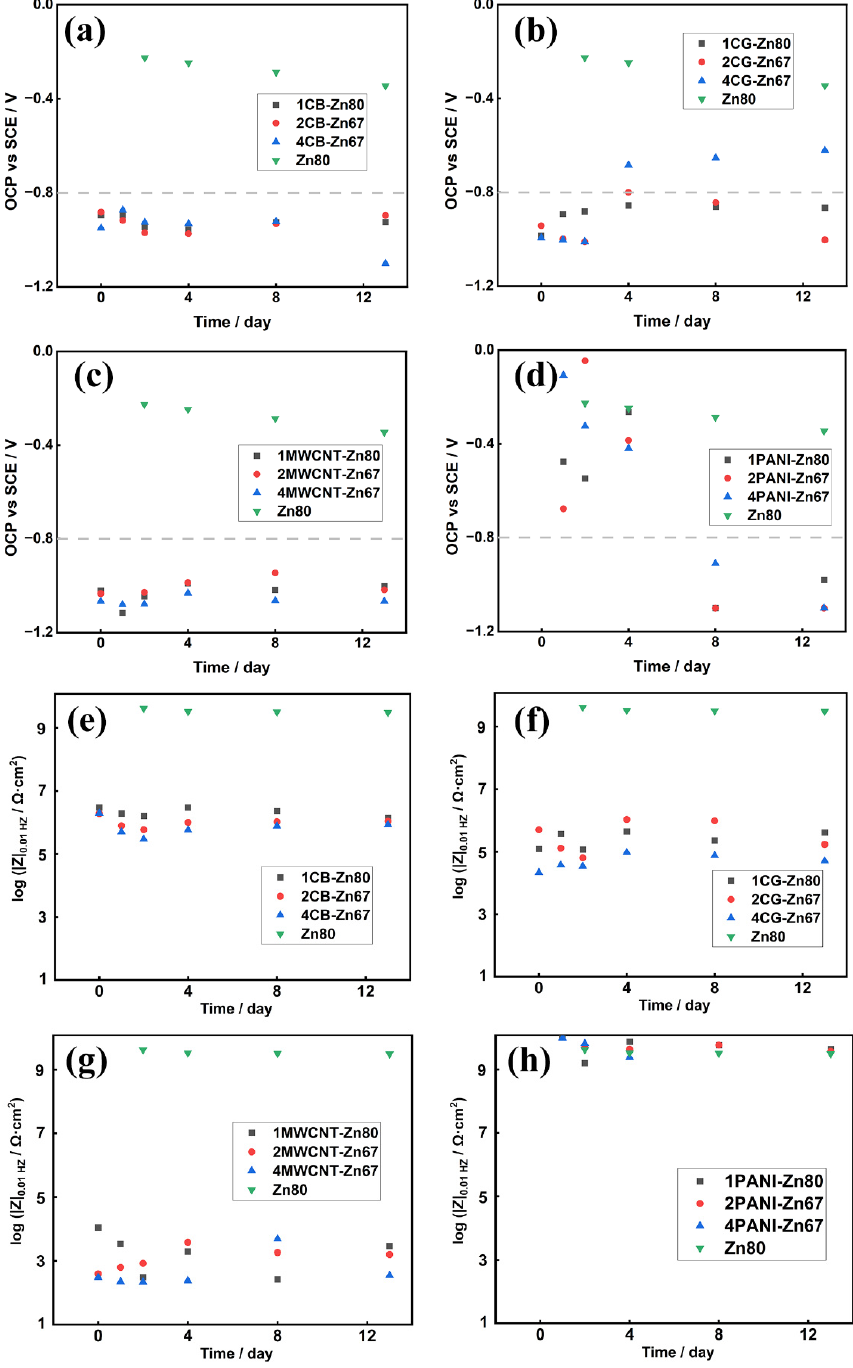
Figure 7. OCP and R p values of XCB-YZn series ( a , e ), XCG-YZn series ( b , f ), XMWCNT-YZn series ( c , g ) and XPANI-YZn series ( d , h ).